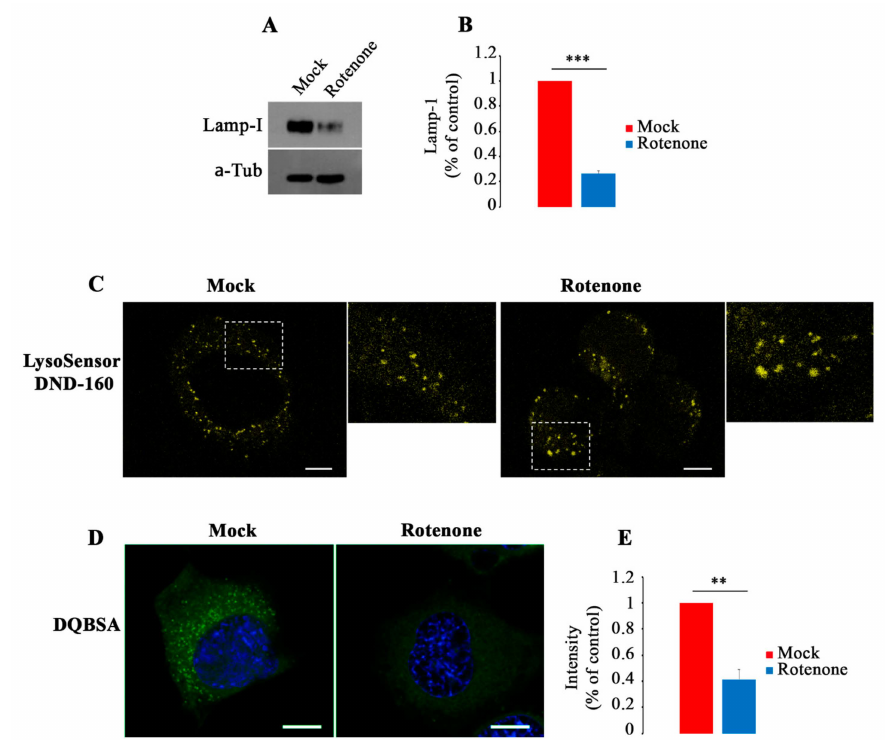
Figure 7. Rotenone induces lysosomal dysfunction in NCS34 cells. ( A , B ) Abundance of Lamp-I was evaluated by Western blot analysis and quantified by densitometric analysis normalizing against α -tubulin. ( C ) Staining with LysoSensor DND-160 (yellow) in Mock and Rotenone-treated (100 nM) cells showing increased staining of enlarged lysosomes after treatment. Dashed boxes represent zoomed areas on the right. Scale bar: 10 µ m. ( D , E ) Cells were incubated in the presence of Green DQ-BSA and nuclei were labeled with DAPI (blue). Fluorescence intensity was quantified by ImageJ software. Scale bar: 10 µ m. Data represent the mean ± SE of at least three independent experiments (* p ≤ 0.05, ** p ≤ 0.01 *** p ≤